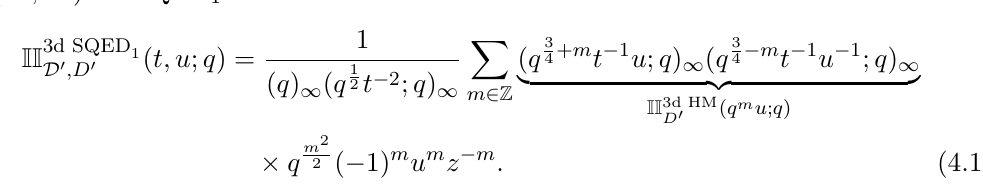
(cid:31) , D ) for T D